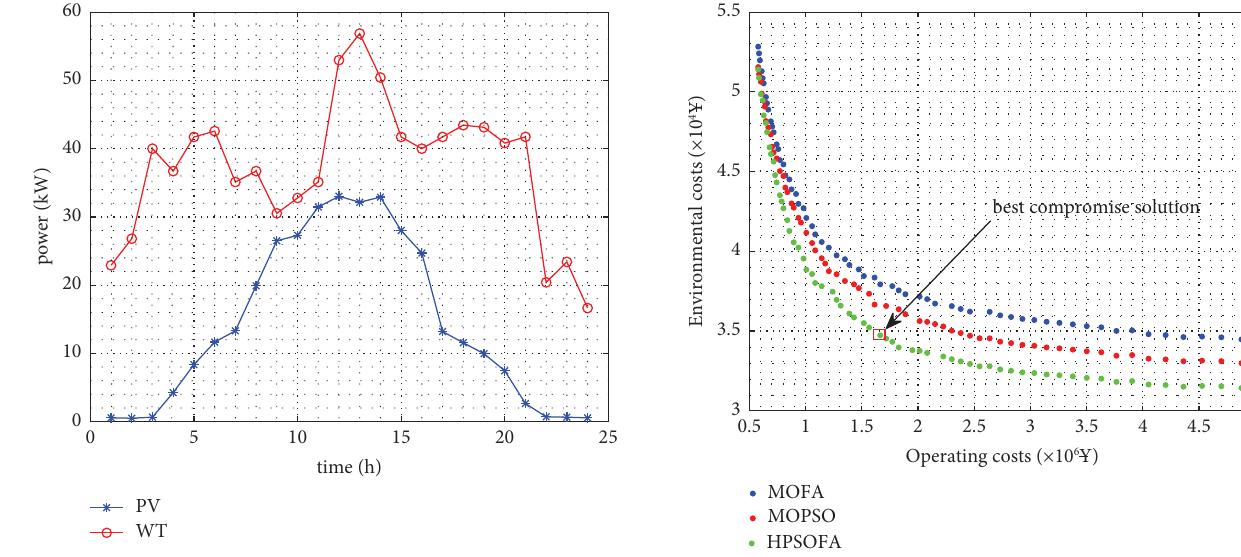
Figure 4: Predicted output of wind turbines and photovoltaic cells.